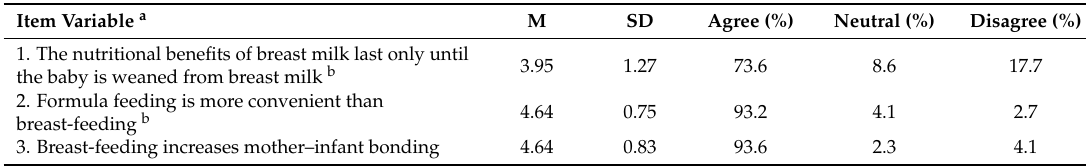
Table 2. Mothers’ attitudes towards breastfeeding using the